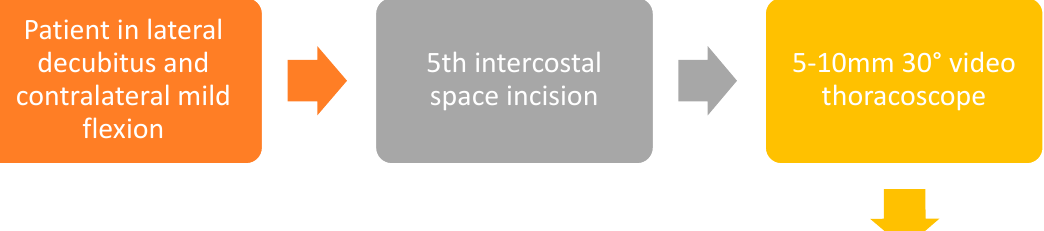
Table 1. N1 and N2 involvement in